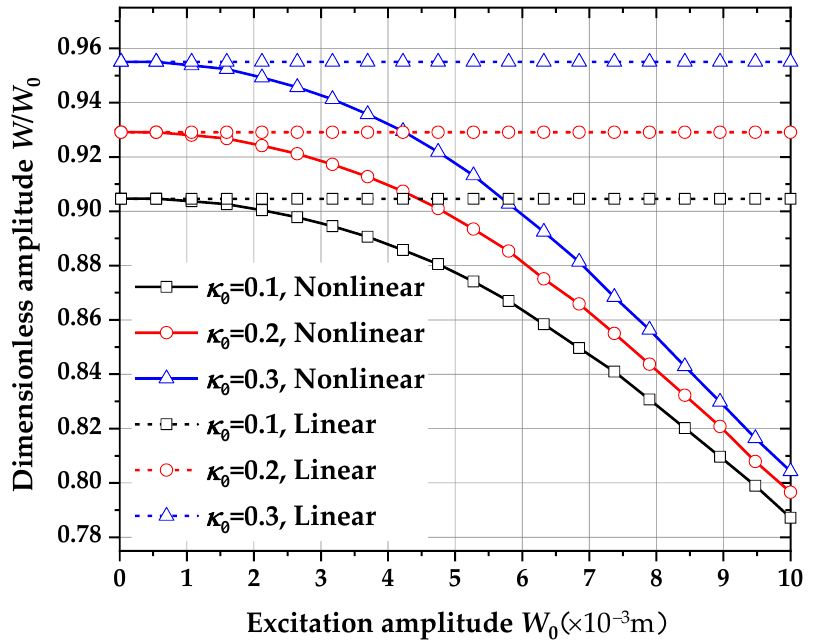
Figure 15. Dimensionless amplitude ( W max / W 0 ) – excitation amplitude ( W 0 ) curves for linear/non-